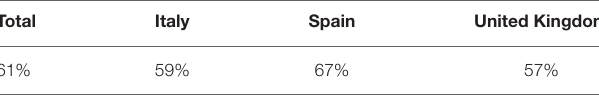
ThesurveywascarriedoutbyOpenEvidence,aspinoffofUniversitatObertadeCatalunya (UOC), realized with the contribution of BDI- Schlesinger Group and Università degli Studi di Milano, Universitat Oberta de Catalunya, Universidad Nacional de Colombia,